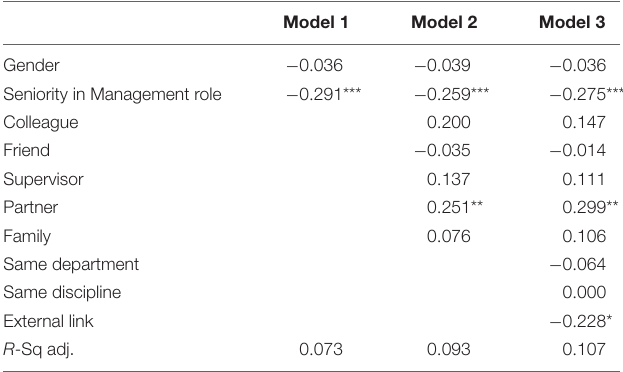
TABLE 2 | Regression model of strength of external connector contact (i.e.,